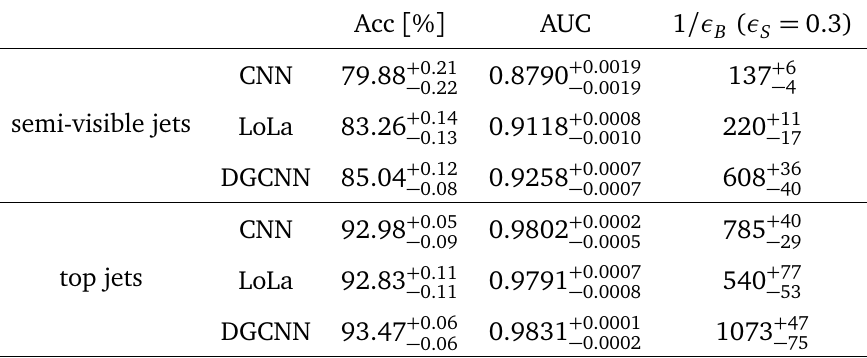
Table 1: Performance measures for classifying semi-visible jets and top jets by the CNN, LoLa and DGCNN architectures, respectively, corresponding to the ROC curves presented in figure 3. We show the accuracy, the AUC value and the background rejection at a signal efficiency of 30%. The central value is the mean of the five independent training runs of the network, while the error estimate corresponds to the spread in the